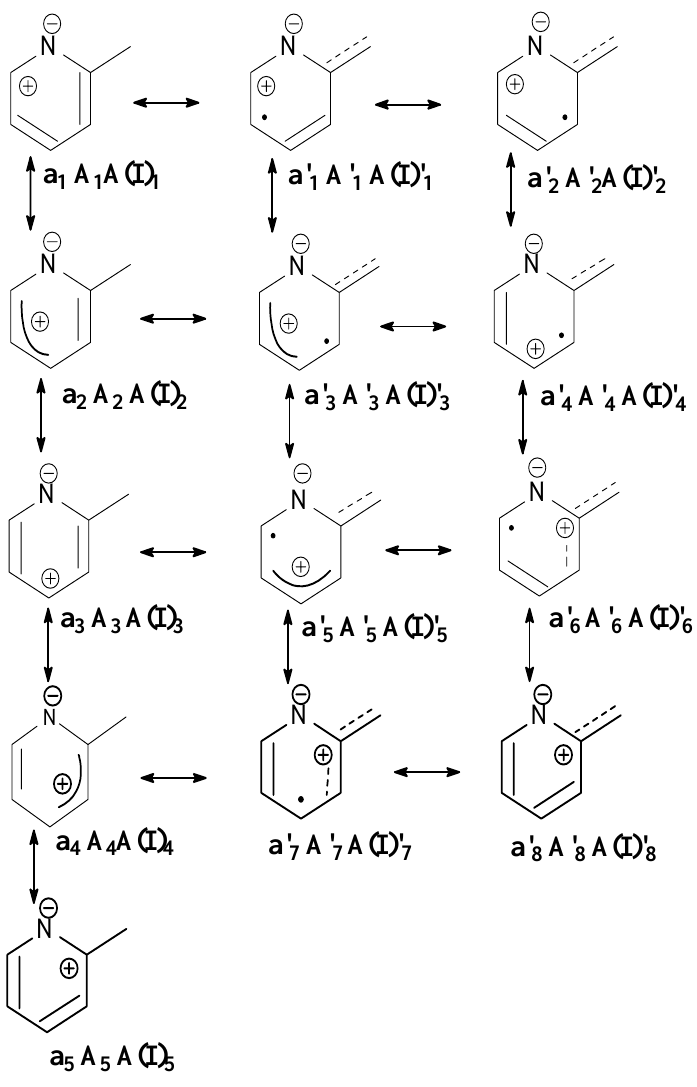
Figure 8 . The resonance structures of the pyridyl